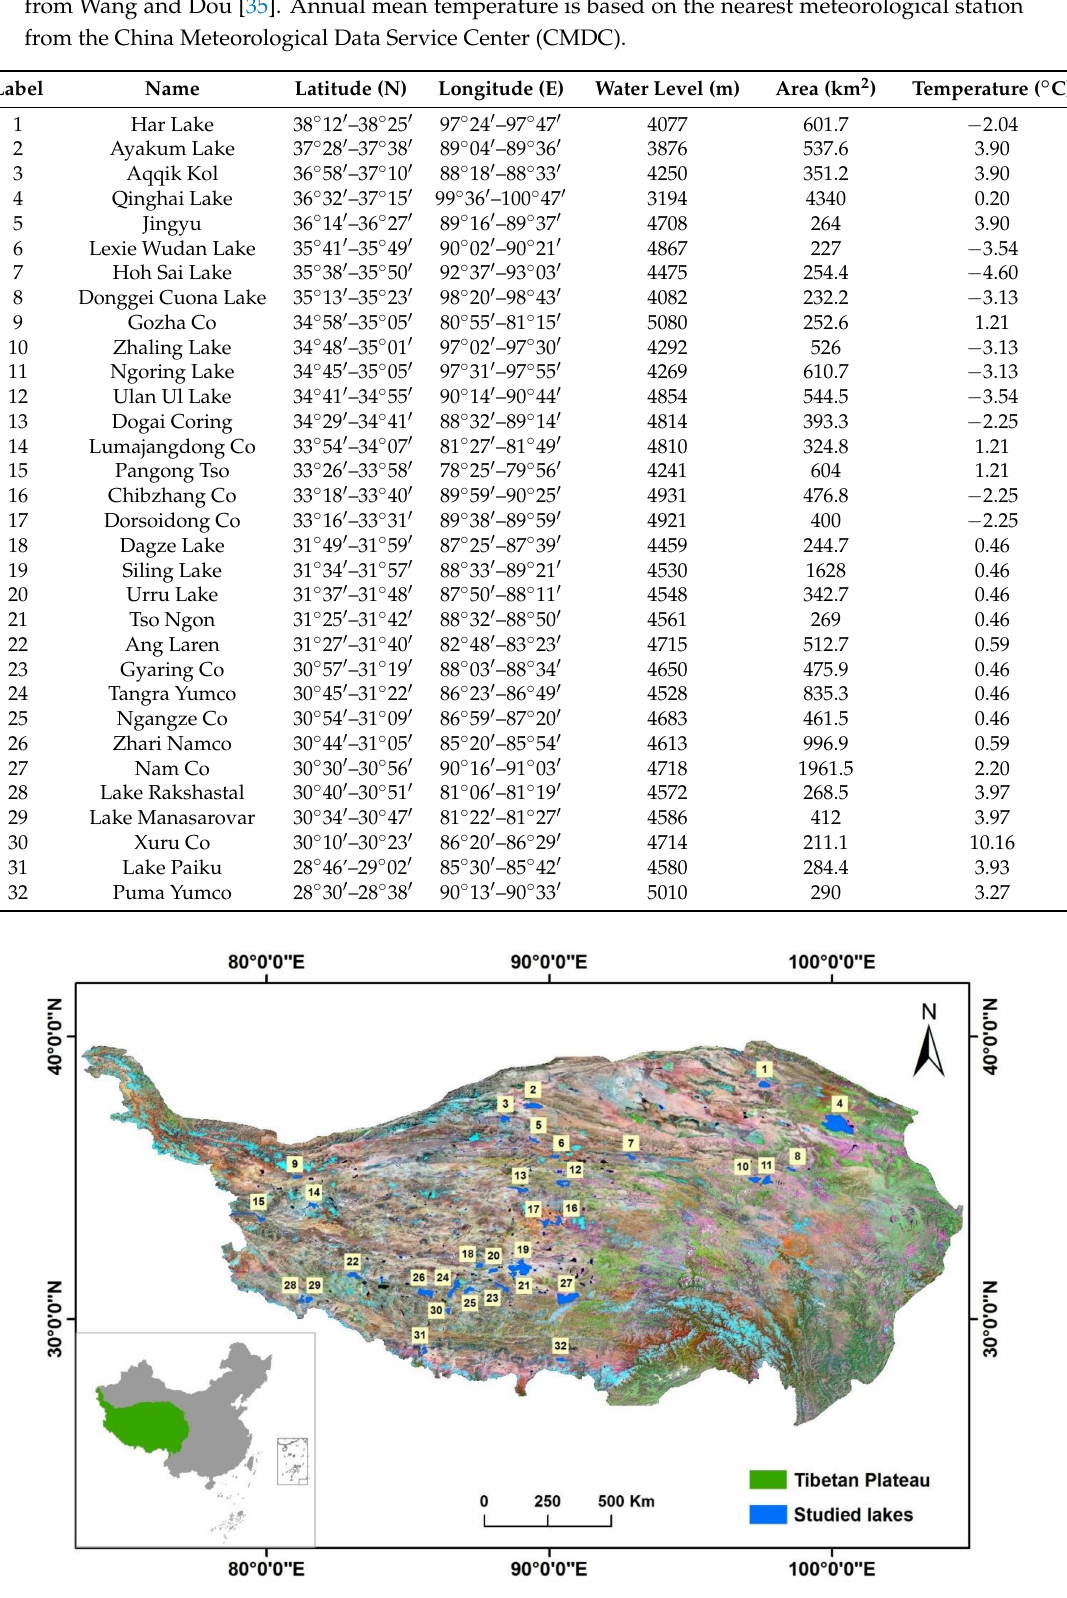
Figure 1. Locations of selected lakes in the Tibetan Plateau (numbered in order of